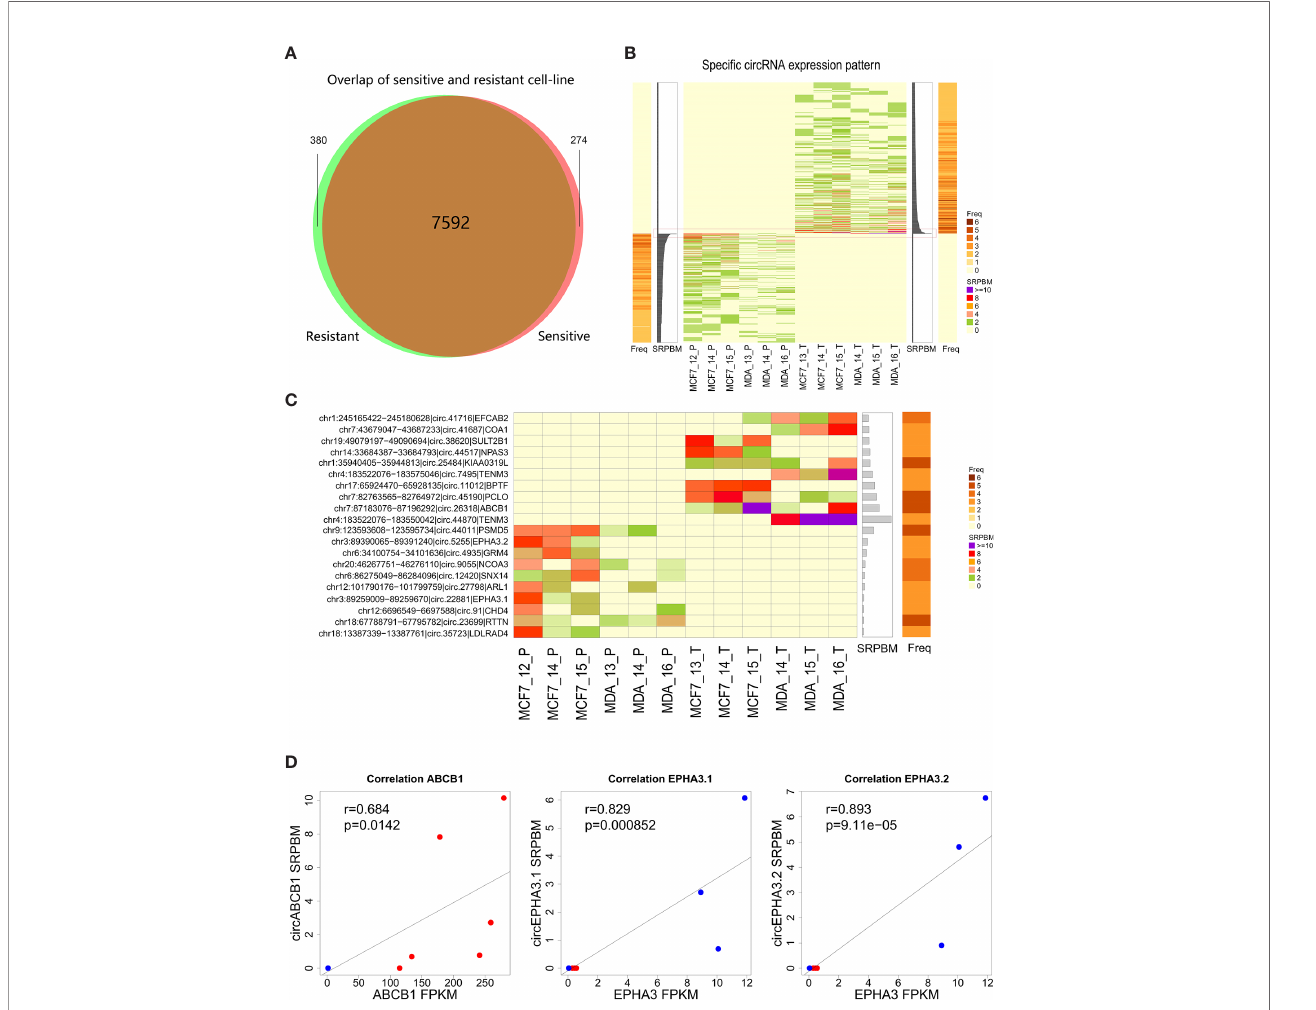
FIGURE 2 | Expression level of circRNA speci fi cally detected in docetaxel-resistant or -sensitive cells. (A) The intersection of circRNAs detected in docetaxel- resistant and -sensitive cells after fi ltering. (B) CircRNAs speci fi cally detected in the docetaxel-resistant and docetaxel-sensitive groups. The central heatmap indicates the expression level (SRPBM) of 654 speci fi cally expressed circRNAs in each sample. The bar plot next to the central heatmap indicates the sum of SRPBM in all samples of a circRNA. The bar plots on the left or right indicate the frequency of a circRNA detected in the samples. The red rectangle marks the top 10 circRNAs speci fi cally detected in the docetaxel-resistant or -sensitive groups. (C) Detailed information for the top 10 circRNAs speci fi cally detected in the docetaxel-resistant or -sensitive groups. (D) Correlation of the three highly abundant circRNAs and their linear isoforms from the same